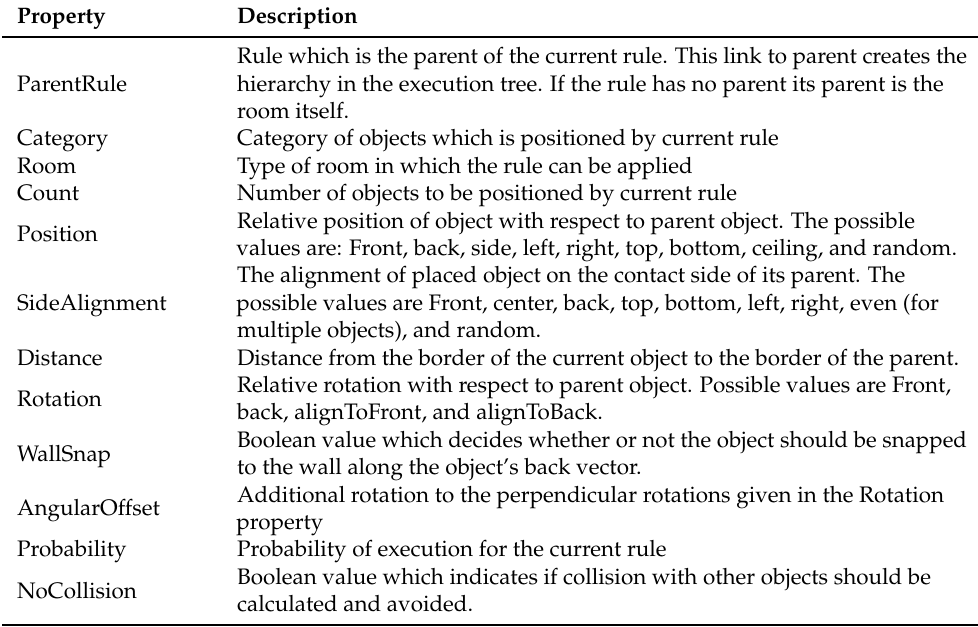
Table 1. Properties of our procedural